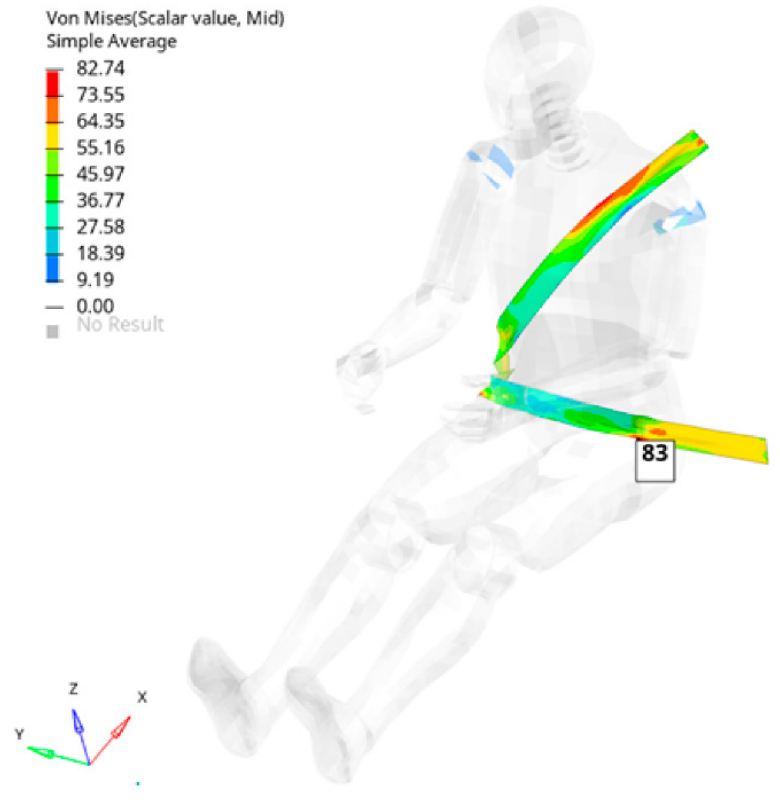
Figure 13. Stress in the belt when T = 0.030 s (in MPa).